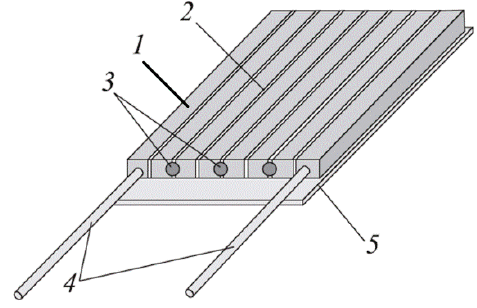
Figure 2. Bismuth-based gradient heat flux sensor, (1) single plate of bismuth; (2) insulation; (3) solder; (4) connecting terminals; (5) mica base [21]. Copyright Springer 2012.